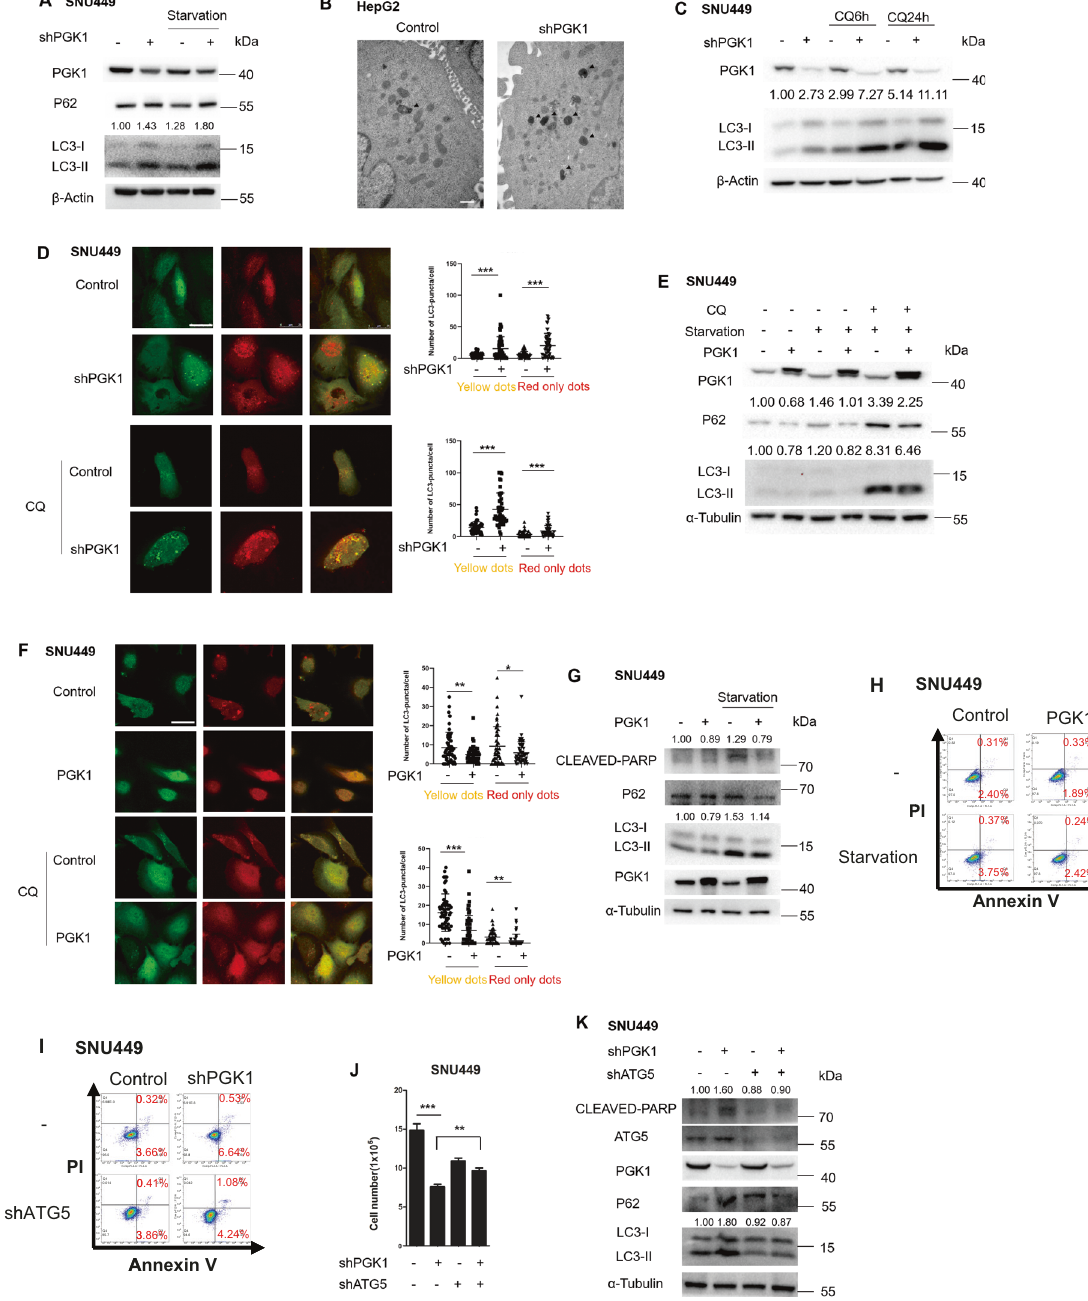
Fig. 4 The association of PGK1 with autophagy-mediated cell death. A – C PGK1 shRNA was introduced into the indicated cells. Cells were cultured in normal or serum-free media (starvation) for 6 h, followed by western blotting analyses ( A ). Images were taken by transmission electron microscopy. Autophagosomes were signed with arrow heads. Scale bar, 500 nm ( B ). Cells were treated with or without CQ (10 μ M) for indicated times, followed by western blotting analyses ( C ). D The indicated cells transfected with mRFP-EGFP-LC3 were treated with or without CQ (10 μ M) for 6 h, and representative micrographs for LC3 puncta were shown. Scale bar, 25 μ m. The puncta were counted in more than 50 cells of each treatment, and the numbers of autophagosomes (yellow dots) and autolysosomes (red only dots) per cell were plotted. E – H FLAG-PGK1 expression vector was introduced into the indicated cells. The indicated cells were cultured in normal or serum-free media (starvation) with or without CQ (10 μ M) for 6 h ( E ). The indicated cells transfected with mRFP-EGFP-LC3 were treated with or without CQ (10 μ M) for 6 h, and representative micrographs for LC3 puncta were shown. Scale bar, 25 μ m. Quanti fi cation results were shown in right panel ( F ). The indicated cells were cultured in normal or serum-free media (starvation) for 24 h, followed by western blotting analyses ( G ). The indicated cells were stained with PI and Annexin V, followed by fl ow cytometry ( H ). I – K The cells transfected with control or ATG5 shRNA (shATG5) were introduced with or without PGK1 shRNA. Cells were stained with PI and Annexin V followed by fl ow cytometry ( I ), counted 48 h later ( J ) or cell lysate was applied to western blotting ( K ). Data represent mean ± SD. * P < 0.05; ** P < 0.01; *** P < 0.001. The quanti fi cation results of the band density (LC3-II and CLEAVED-PARP) were labeled above the